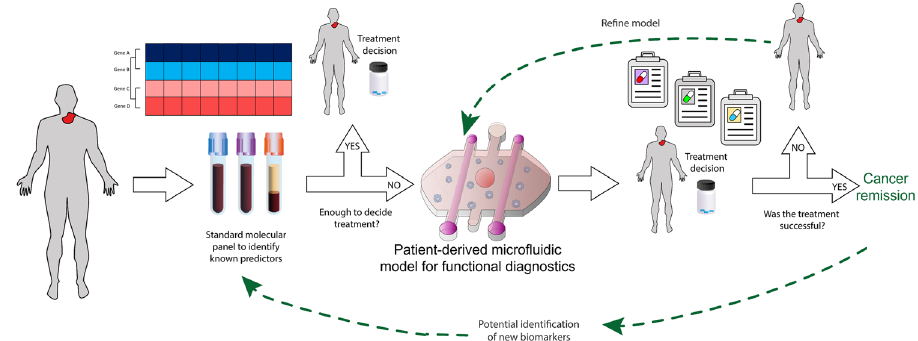
Fig. 5 Potential work fl ow for micro fl uidic devices in molecular and functional diagnostics. Patients are fi rst subjected to standard molecular panels to identify known predictors. If molecular data is insuf fi cient to make a clinical decision on patient treatment, tissues of interest would be sampled to build an organotypic model for functional drug testing. This model would be used to test several potential drugs (and drug combinations), and then compared to the patient outcome for validation. Several steps of model enrichment may be needed. Ideally, the organotypic model would lead to the identi fi cation of new biomarkers, or to a simpler model that can be integrated into the